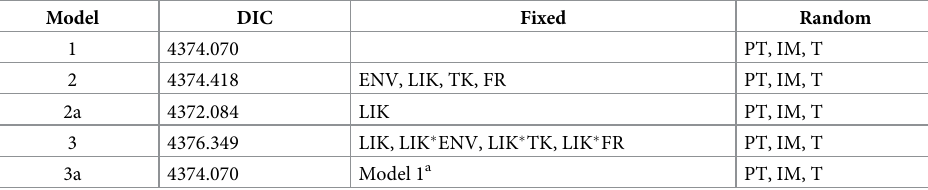
Table 1. Model fit comparisons for models with standardised velocity as a dependent